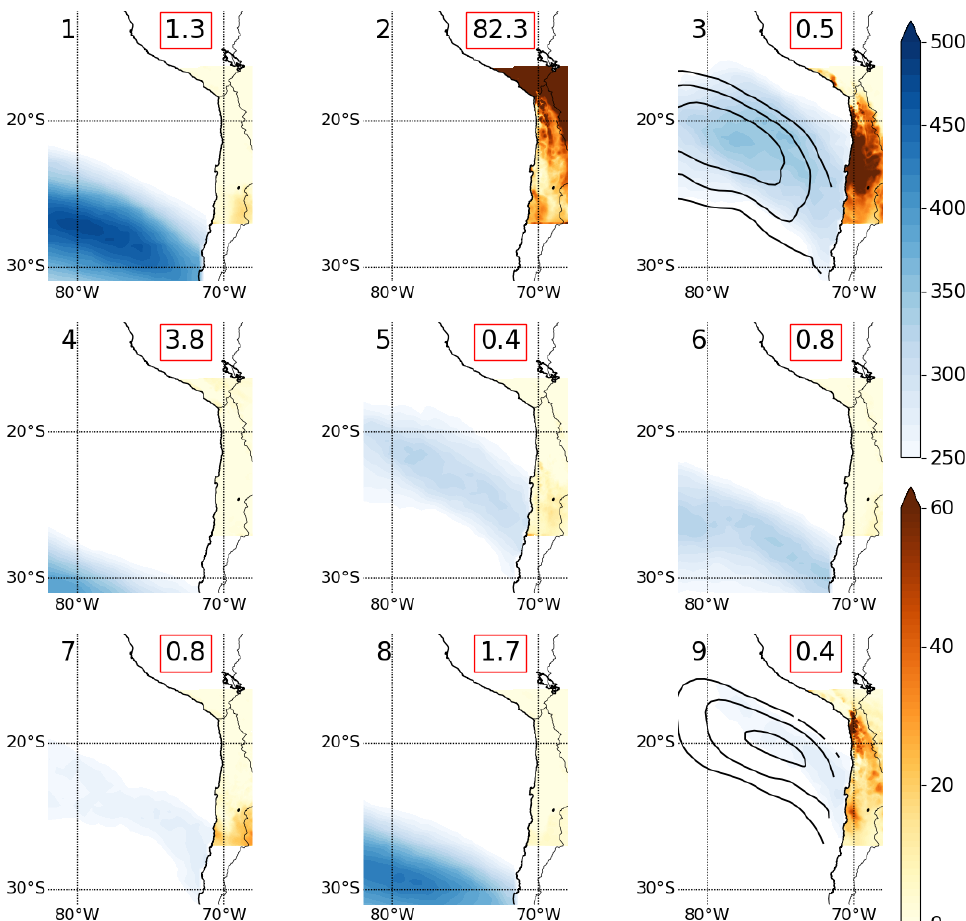
Figure 9. As Fig. 8 but for WRF hist . The black contours in cluster 3 and 9 show the composite mean wind speed at 4000ma.s.l. (15, 17 and 19ms − 1 ).